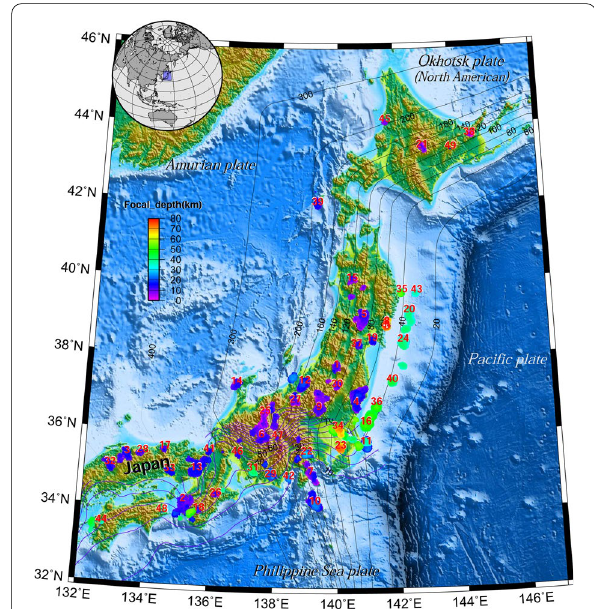
Fig. 1 Spatial distribution of the 49 seismically dense spheres (SDS). The background color is the surface elevation (km) from the Etopo digital elevation model (Smith and Sandwell 1997). The black and violet lines indicate the iso-depth (km) contours of the upper surface of the subducted Pacific (PAC) and Philippine Sea (PHS) plates (Nakajima and Hasegawa 2007). The overlapping colored circles marked by numbers 1 to 49 are the seismically dense